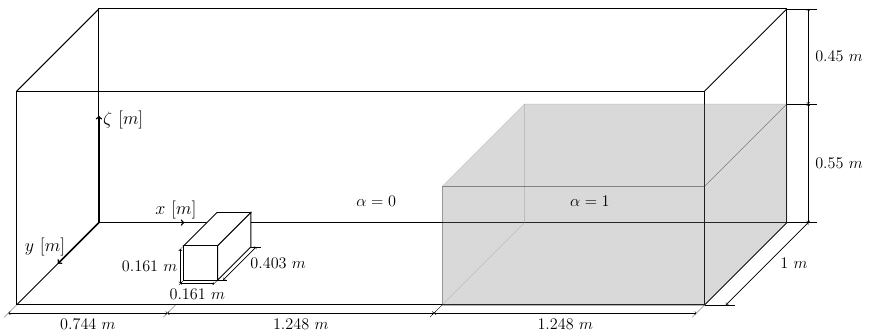
Figure 21. Setup for the three-dimensional breaking of a